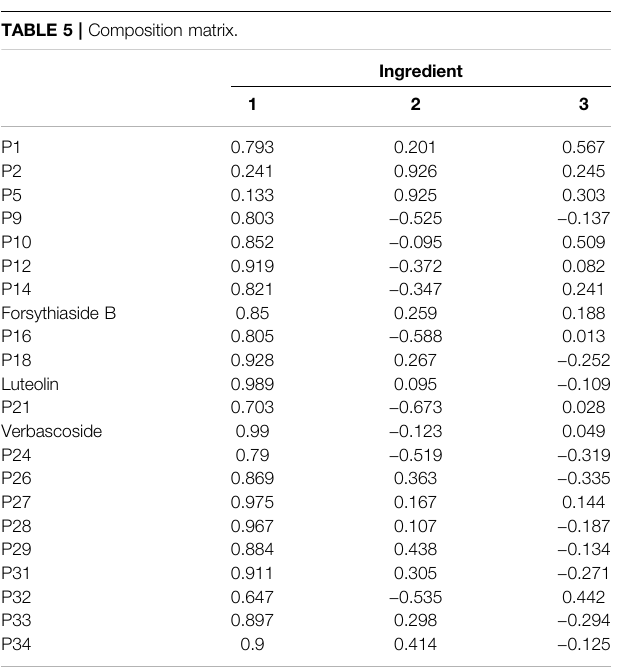
TABLE 5 | Composition matrix.